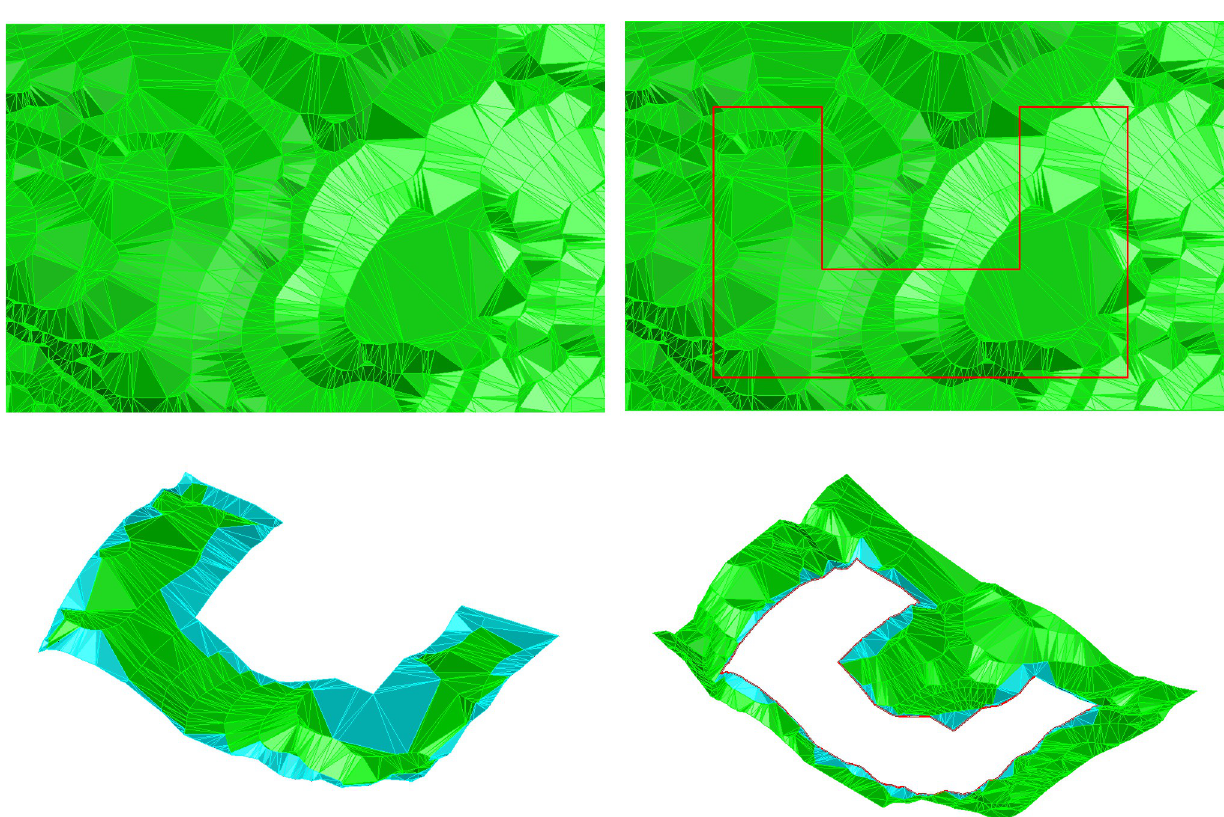
Fig 8. TIN clipping with a concave